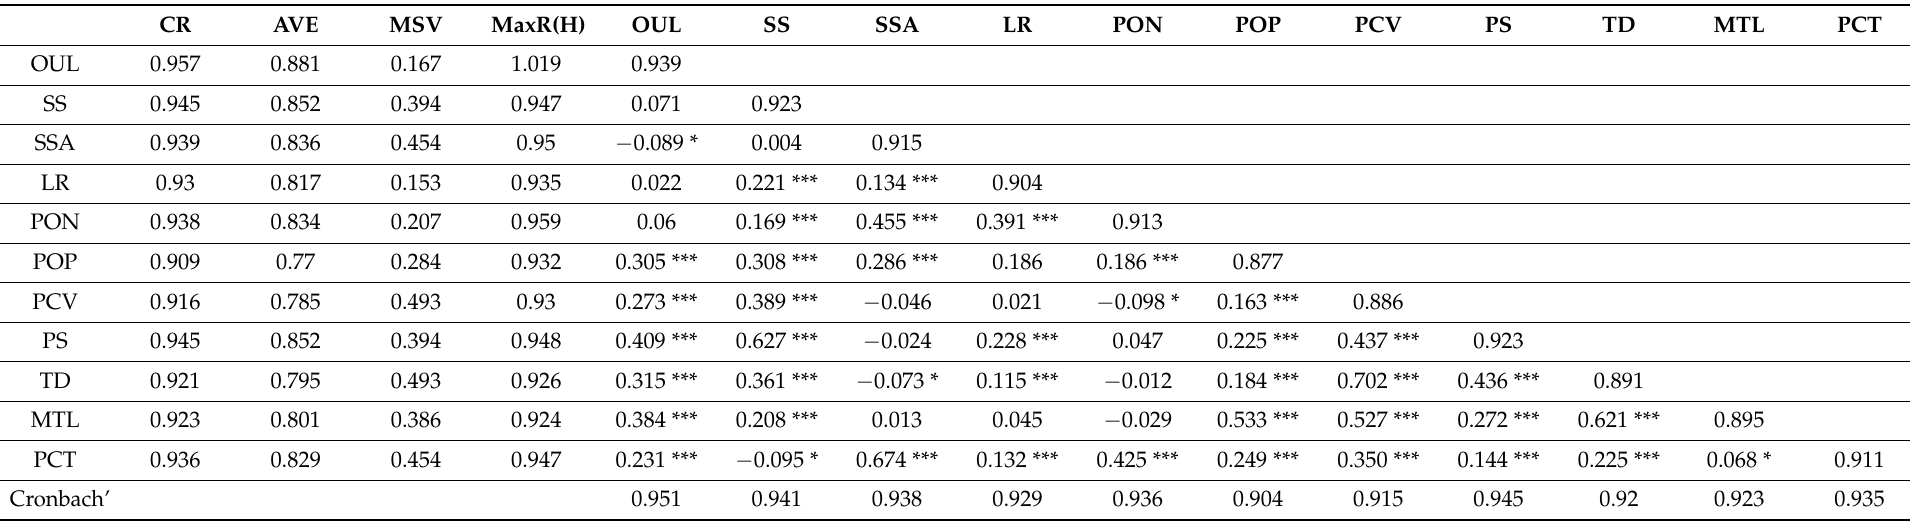
Table 5. Reliability and AVE Convergent Validity of Training in the Specific Domain ( n =